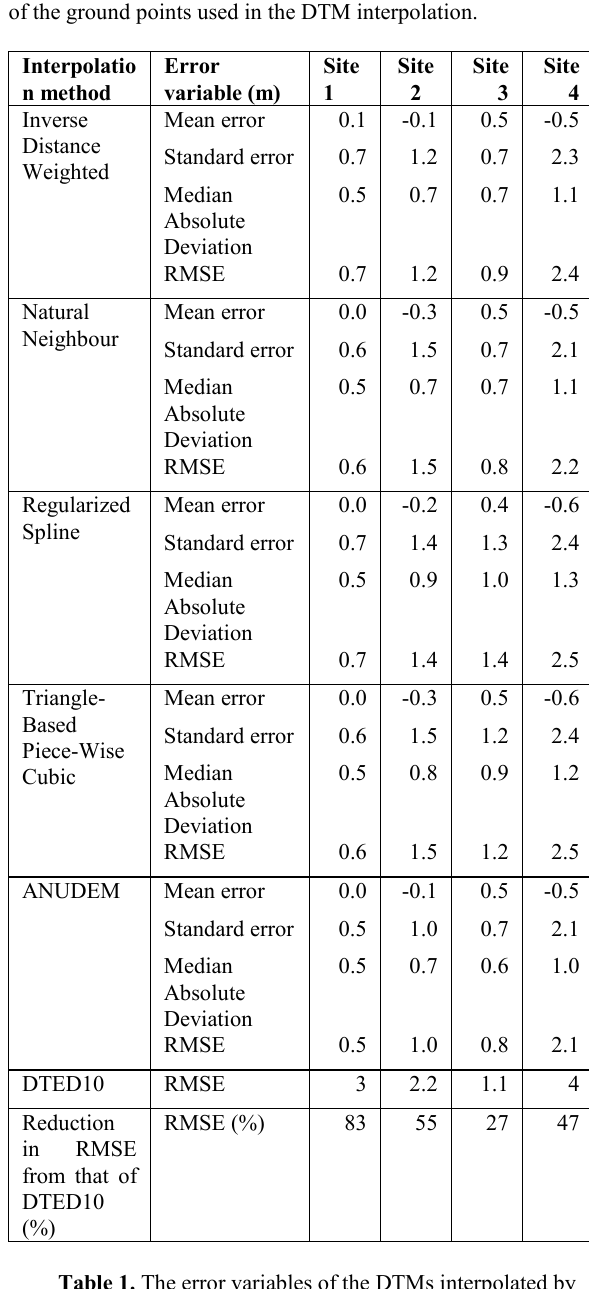
Table 1. The error variables of the DTMs interpolated by the five different methods for the four test